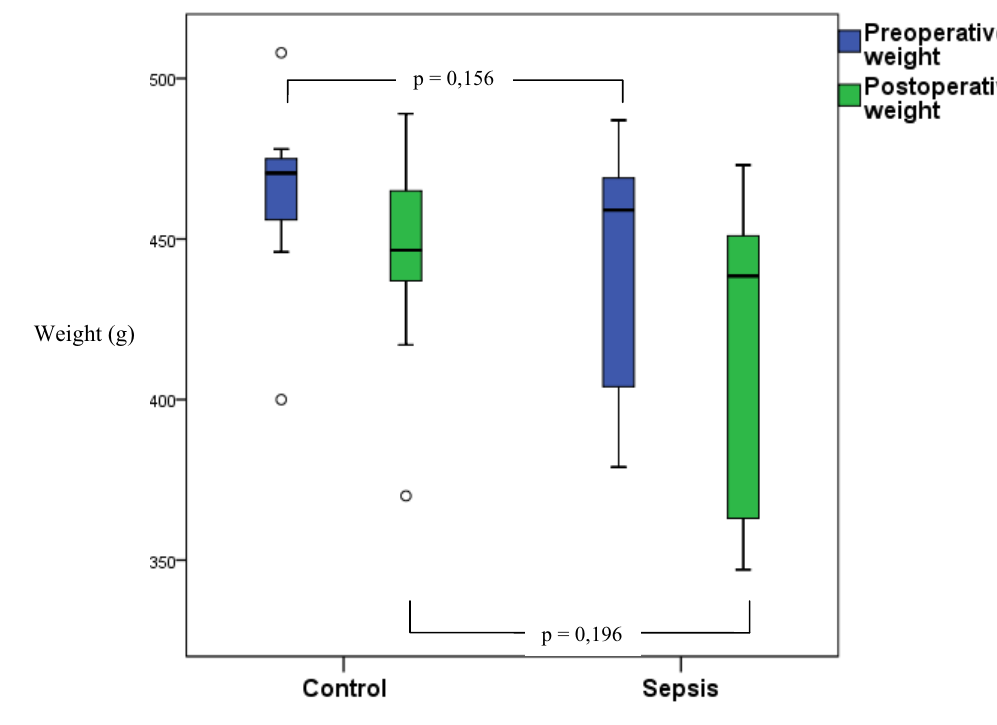
FIGURE 1 - Weight of animals euthanized on the 3 rd postoperative